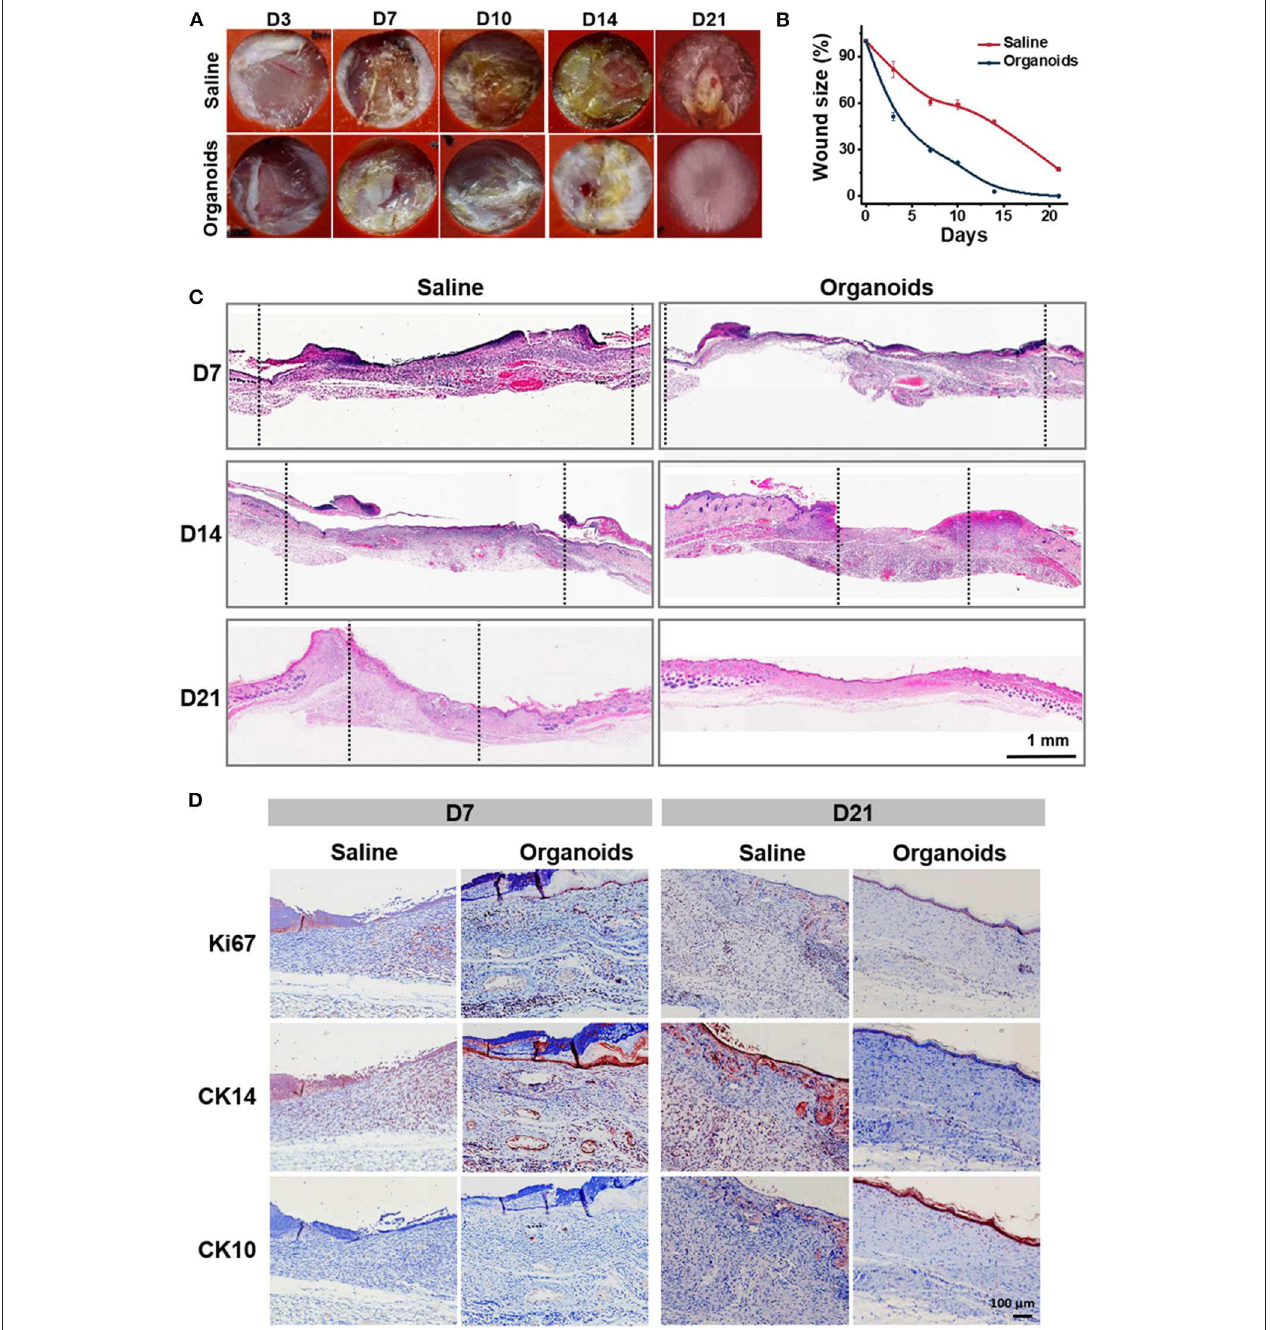
FIGURE 5 | Human skin-derived organoids delivered by the AMAD improved wound healing. (A) Representative images of the mouse wound splinting model after spraying of the skin organoids; the medium without cells was used as the control group. (B) Analysis of wound size (%) of each group, and the wound area over time were measured as a percent of the original area, n = 3. (C) Wound sections on 7, 14, and 21 days after spraying were stained with H&E for general observation of skin layers. (D) Immunohistochemical staining of Ki67, CK14, and CK10 on the skin wound treated by spraying of epidermal organoids vs. control